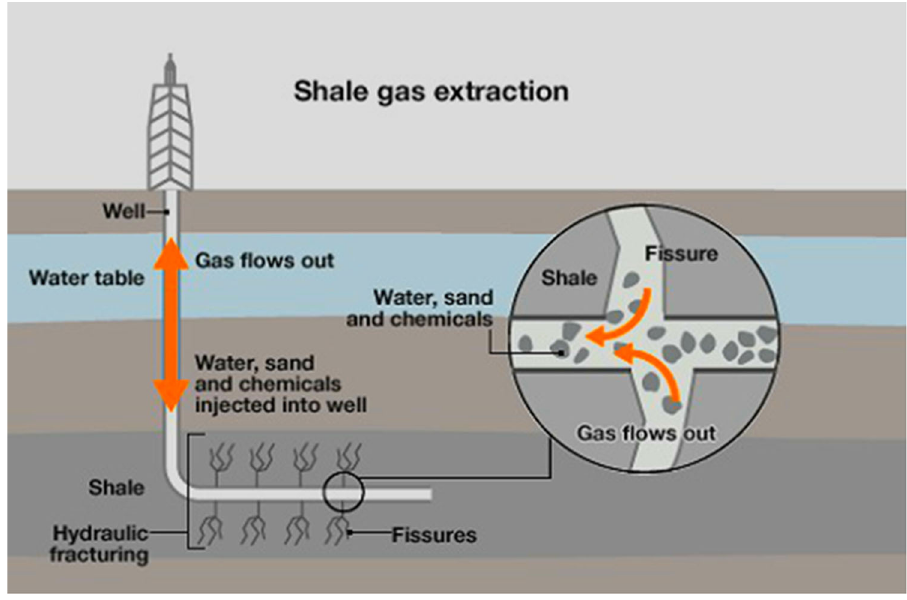
Fig. 5 Pakistan’s natural gas consumption of last few decades Source : BP Statistical Review of World Energy